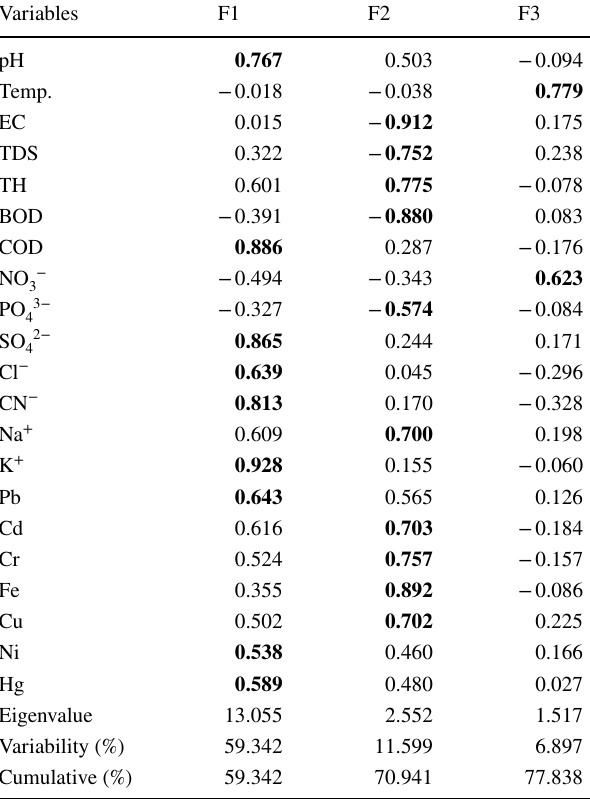
Table 10 Factor loading matrix (after varimax rotation), eigenvalues and variances for water samples